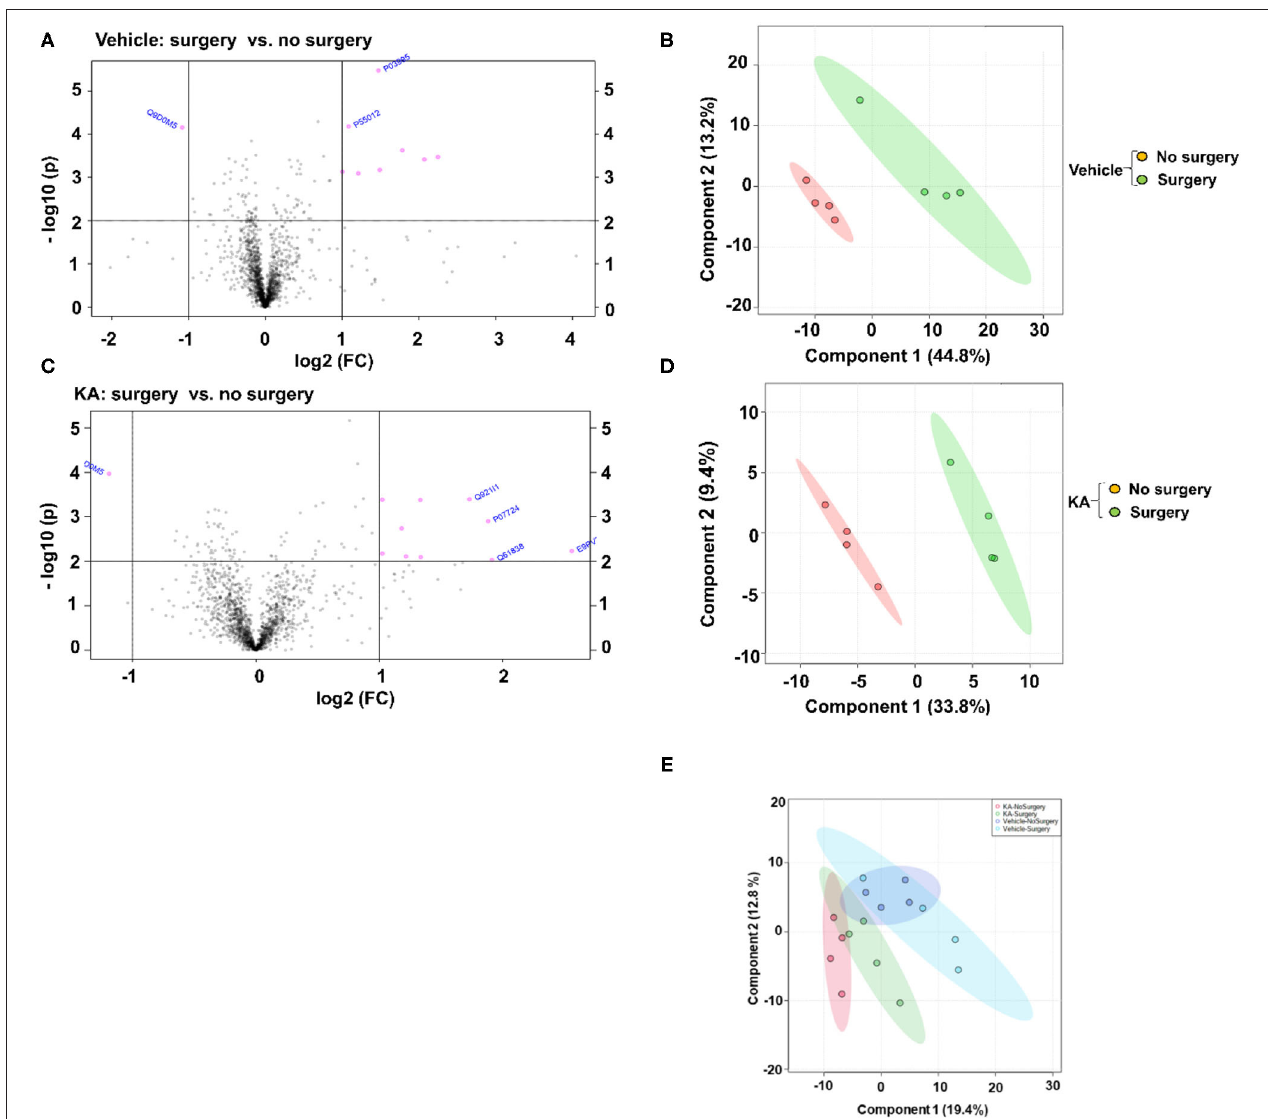
FIGURE 3 | Fold change (FC) analysis of the vehicle or KA treated groups, with or without surgery, with a threshold of 2 was performed to compare the absolute change between group values. The Volcano plots (A,C) were created to show both the fold change and the two-sample t -test analysis. The PCA analysis was performed using the prccomp package, and pairwise score plots (B,D) and all four-way plot (E) represent an overview of the various separation patterns among the most significant